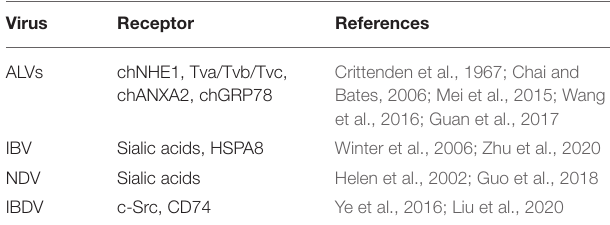
TABLE 1 | Poultry-related virus